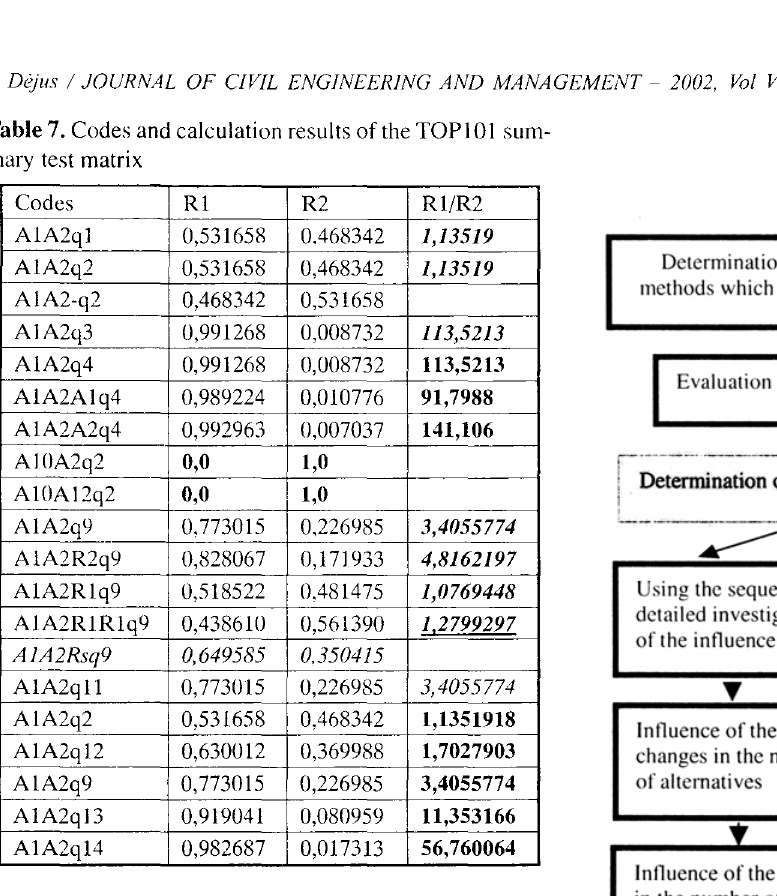
Table 7. Codes and calculation results of the TOPI OJ sum mary test